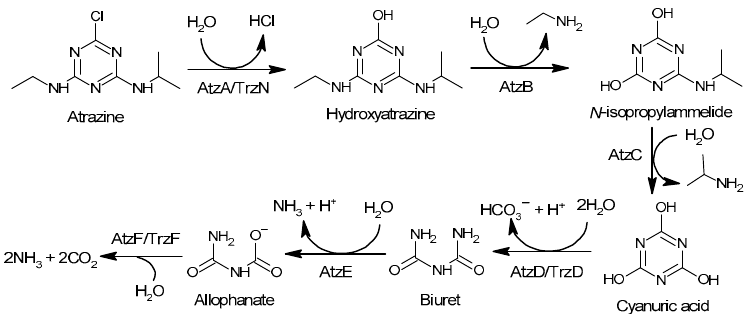
Figure 3. Degradation pathway of atrazine through biotic treatment process.